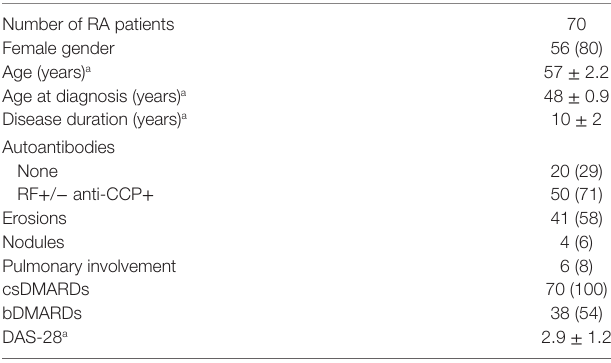
TaBle 1 | Demographic, clinical, and serological features of ra patient cohort.